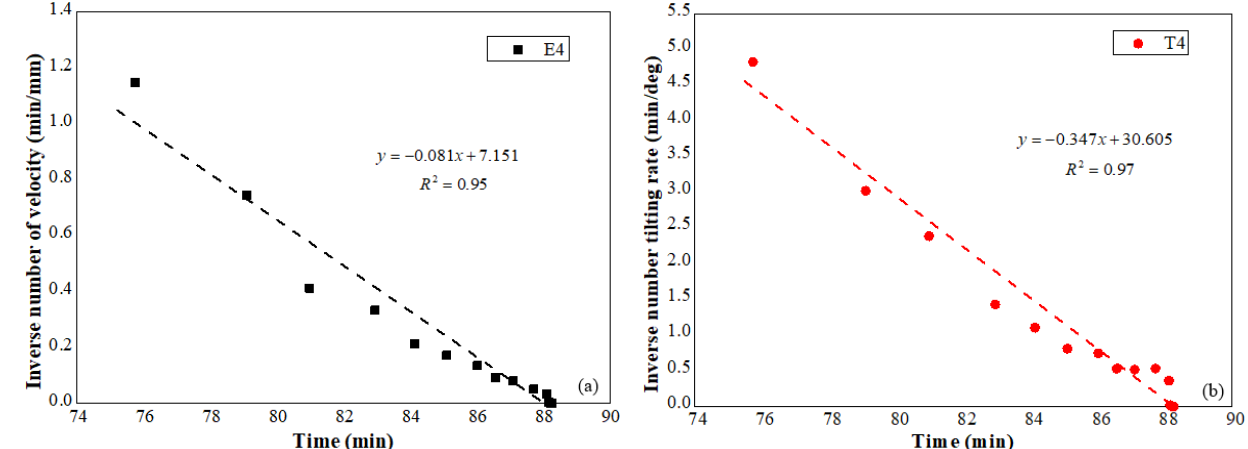
Figure 14. ( a ) Reciprocal displacement rate against time, ( b ) reciprocal tilting rate against